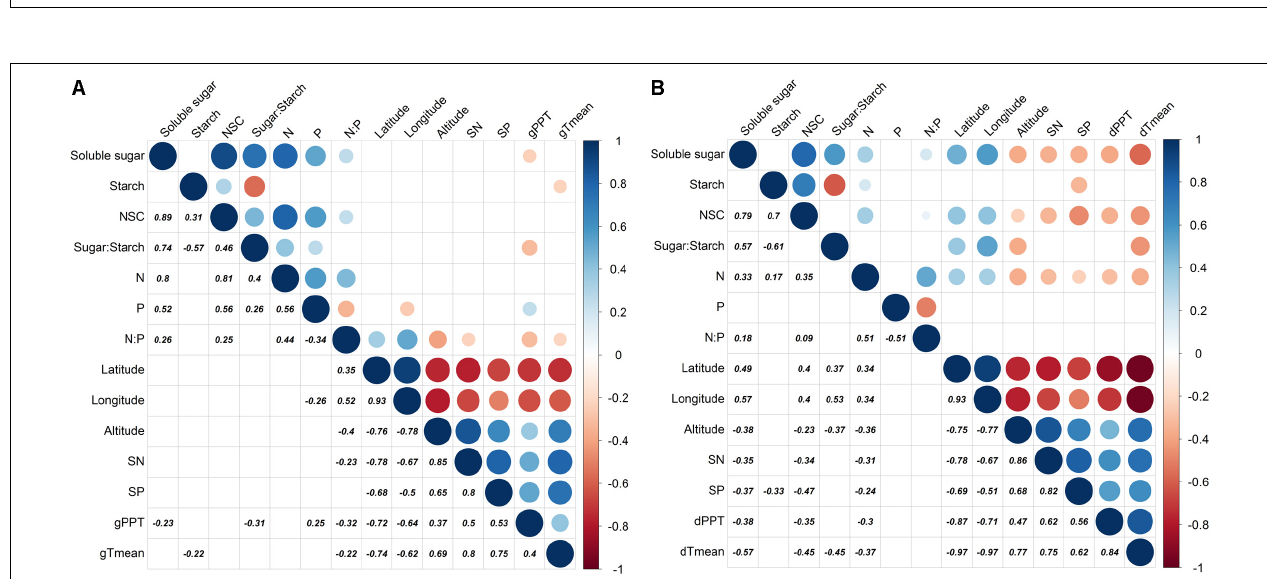
FIGURE 3 | The total nitrogen and phosphorus concentrations (mg/g) (mean ± se, n = 3) across life stages (juveniles vs. mature), tissues (leaf, branch, and fine root), and sampling seasons (growing season: Aug, 2014; and dormant season: Dec, 2014) along the latitudinal gradient. For each subplot, blue color denotes mature individuals and red denotes juveniles; fitted curves, determinant coefficients, and p -values of simple linear regression are given.